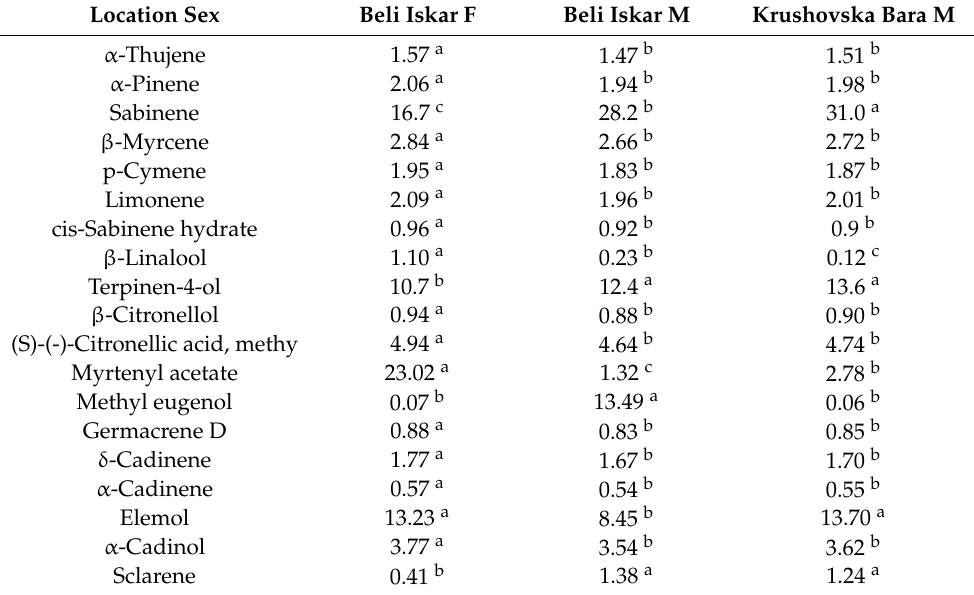
Table 4. Mean concentration (%) of α -thujene, α -pinene, sabinene, β -myrcene, p-cymene, limonene, cis-sabinene hydrate, β -linalool, terpinen-4-ol, β -citronellol, (S)-(-)-citronellic acid methy, myrtenyl acetate, and methyl eugenol, germacrene D, δ -cadinene, α -cadinene, elemol, α -cadinol, and sclarene obtained from the female and male Juniperus sabina at the Beli Iskar location in Bulgaria, and male Juniperus sabina at the Krushovska bara location in Bulgaria. Location Sex Beli Iskar F Beli Iskar M Krushovska Bara M α -Thujene α -Pinene